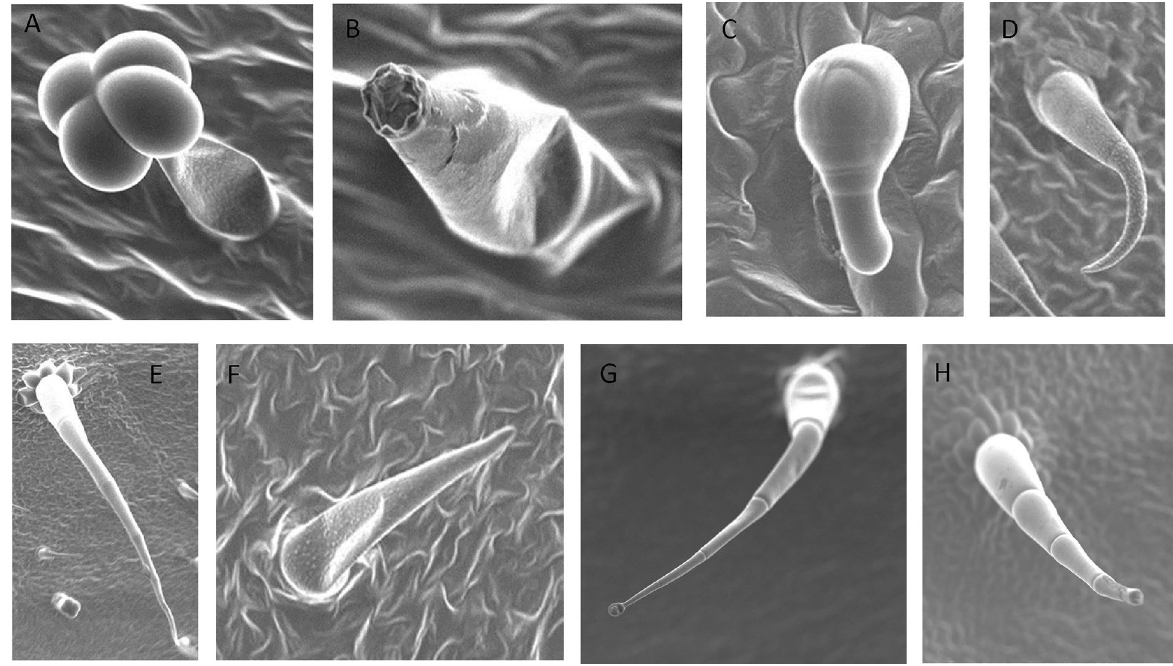
Fig. 2 The major types of glandular trichomes found in tomato. A Glandular trichome with large quadricellular head; B Attenuate glandular hair with small glandular tip; C Glandular hair with large globular head; and non- glandular trichomes found; D Crescent non-glandular with multicellular jointed stalk; E Subulate non-glandular hair with multicellular jointed stalk, multicellular base; F Subulate non-glandular hair with pulvinate base and pedestal; Some other glandular trichomes; G Hooked subulate glandular hair with multicellular jointed stalk and small glandular tip; H Subulate glandular hair with multicellular jointed stalk, multicellular base, small glandular tip. Images captured in Scanning electron microscope at magnification 200–1000 ×